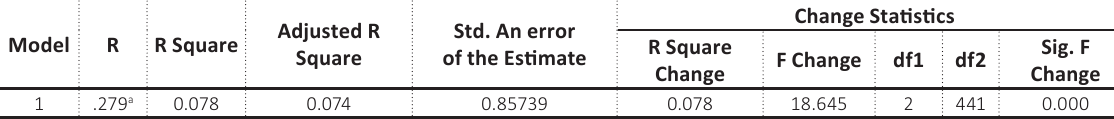
Table 10. Model summary for H